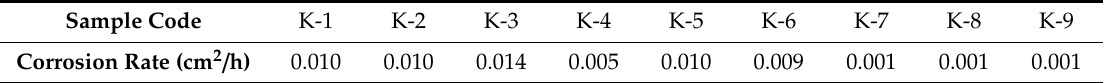
Table 6. Corrosion rates of samples tested in the Kesternich test.